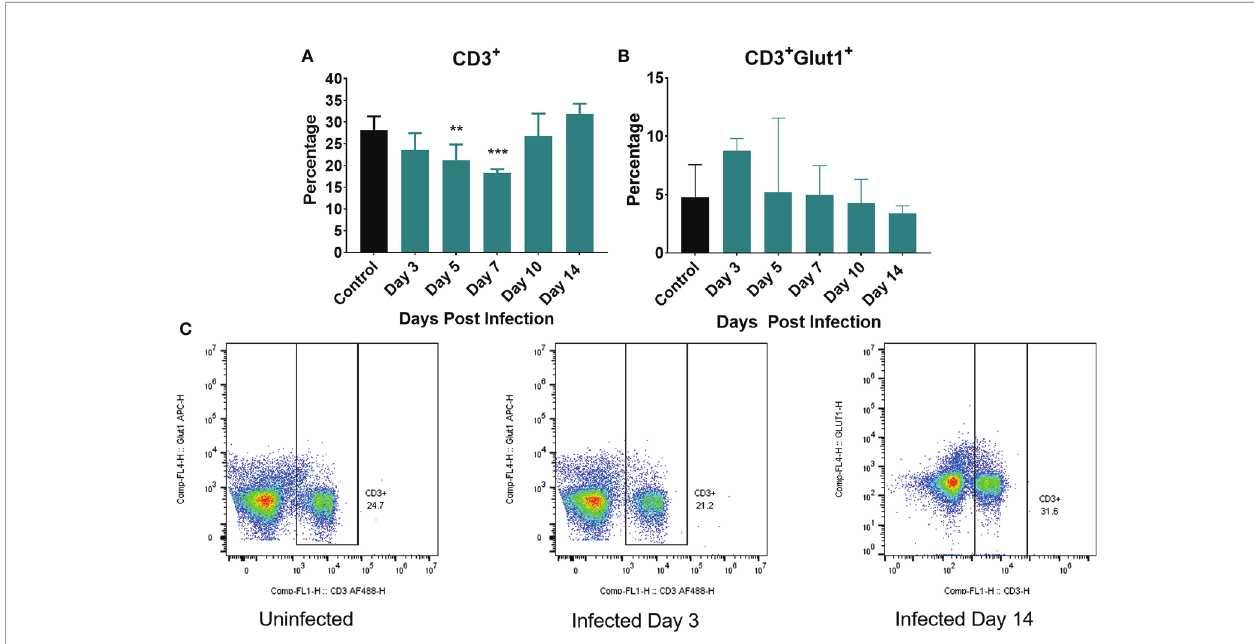
FIGURE 6 | Markers of cellular metabolism of T cells. Percent of splenocytes expressing (A) CD3 + (T cells) and (B) percent of CD3+ cells expressing Glut1 over the course of the infection. (C) Representative fl ow cytometric plots of CD3 and Glut1 on T cells on uninfected controls and at day 3 and 14 post infection. Signi fi cance was assessed using one-way ANOVA followed by a Dunnett Test for multiple comparison. Data are represented as mean ± SD. High Dose (n = 5) - Control (n = 3). *p < 0.05, **p < 0.01, ***p <